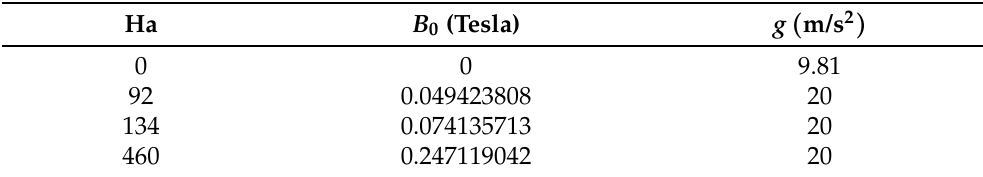
Table 3. Properties used for different Ha in the 3D natural convection problem.